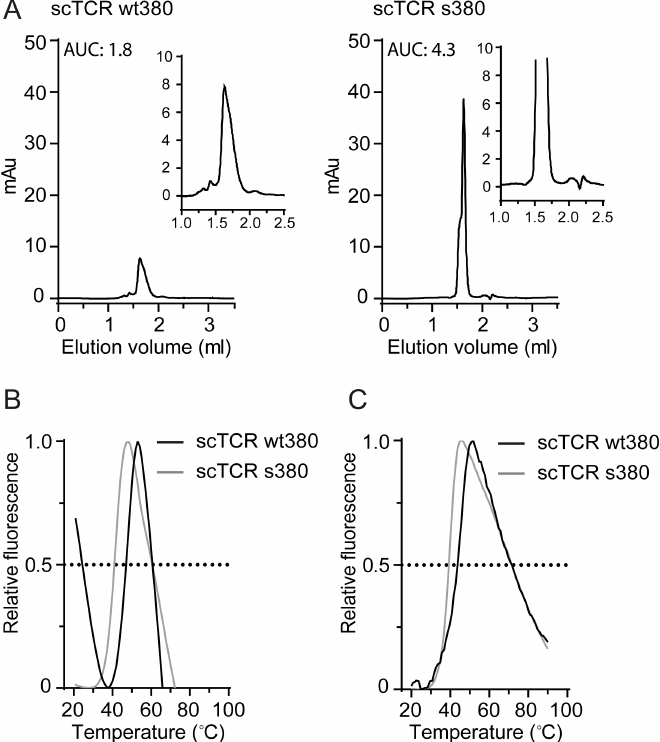
Fig 4. Stability assessment of the scTCRs. (A) Analytical SEC of scTCR wt380 and scTCR s380 to assess the integrity of the preparations after a freeze-thaw cycle ( n = 2). Details of aggregates and monomeric peaks are shown in the magnified inset chromatograms. (B) DSF or (C) fluorescence spectroscopy measurements of scTCRs wt380 and s380 to calculate the melting temperature (T m ) of the variants. The T m values are summarized in Table 2 ( n = 9–10 for DSF measurements and n = 2 for fluorescence spectroscopy measurements).